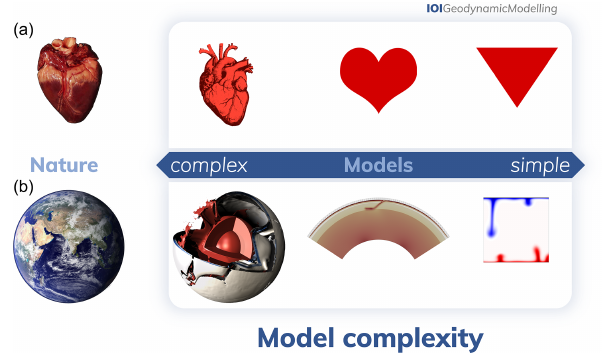
Figure 7. Different model complexities for the heart (a) and the Earth (b) . A simpler model can be more useful: the basic shape of the heart has likely become the most successful model, indeed a true icon, only because it was neither too complex (it can be repro- duced easily) nor too simple (its characteristic shape is still recog- nisable). Finding the right level of complexity is challenging and must repeatedly be considered carefully by the modeller for each new modelling task at